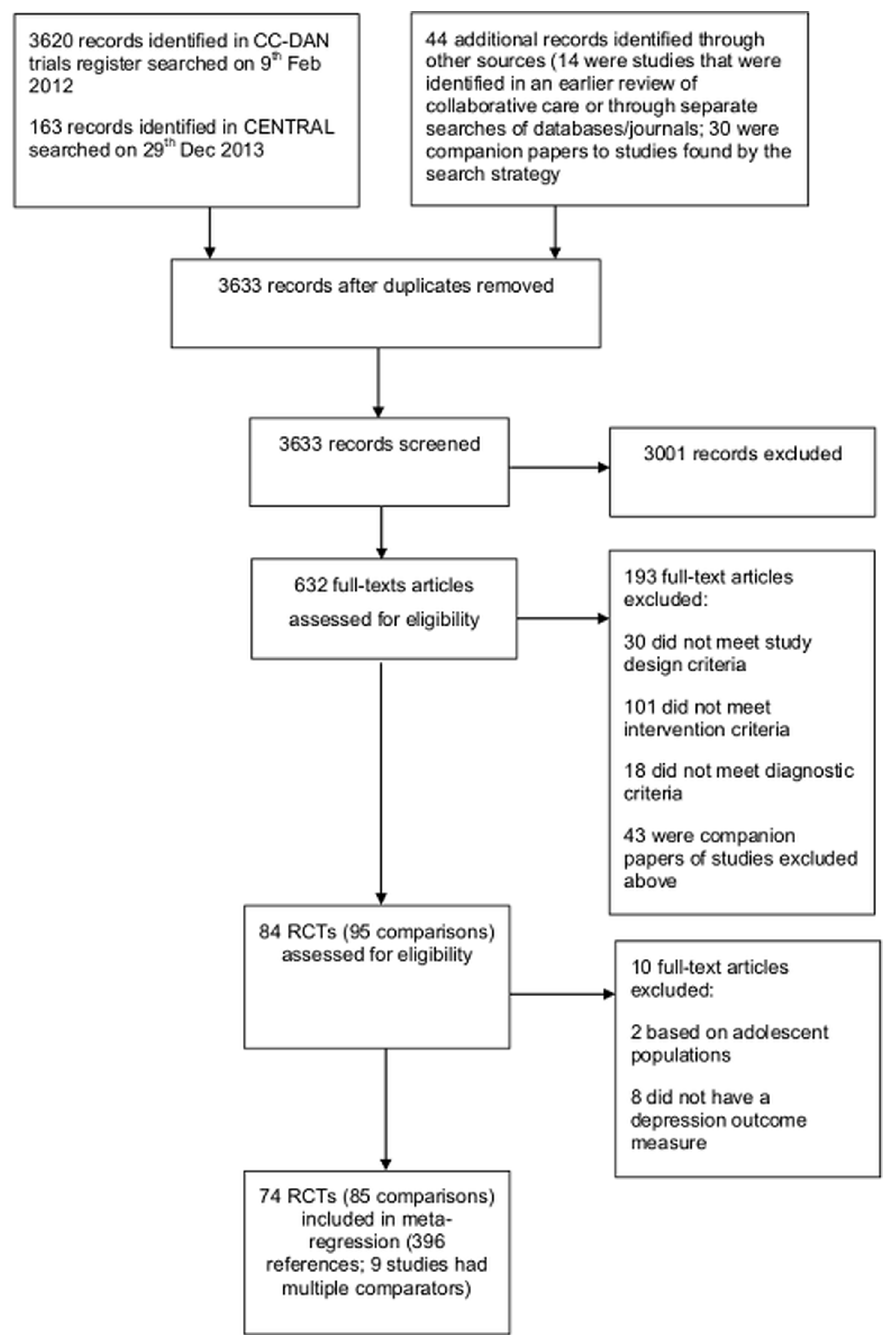
Figure 1. PRISMA Flow Diagram.